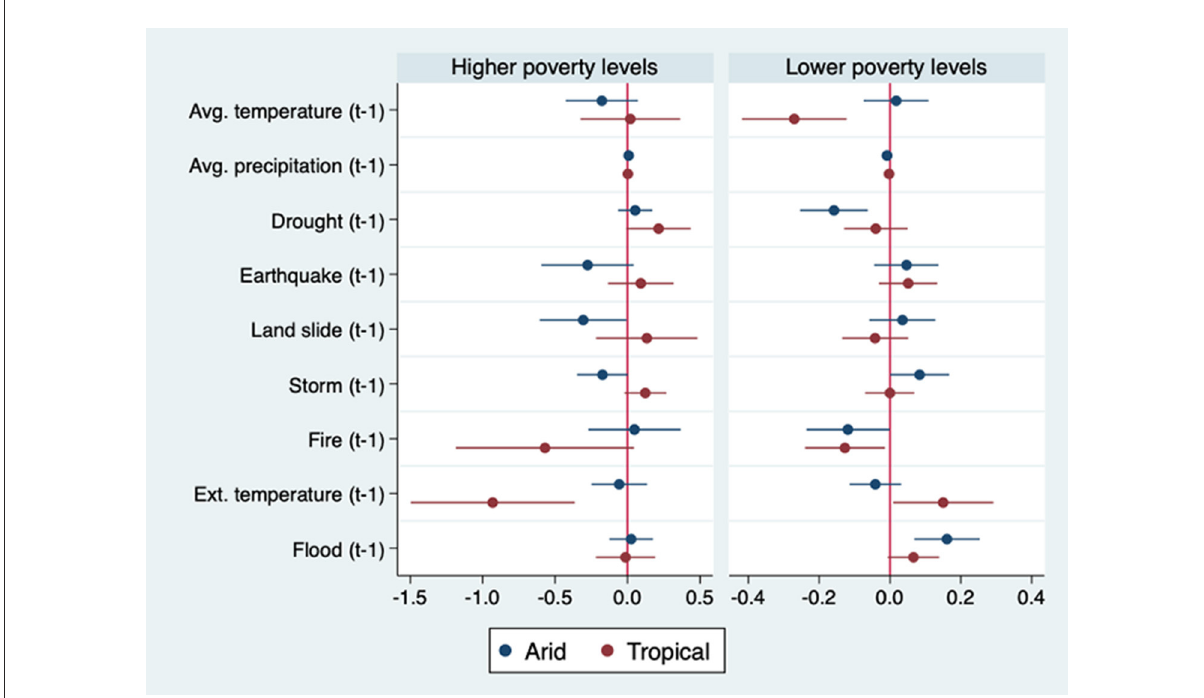
FIGURE2 Coefficients’ plot of the climatic variables, for high and low poverty levels, by arid and tropical